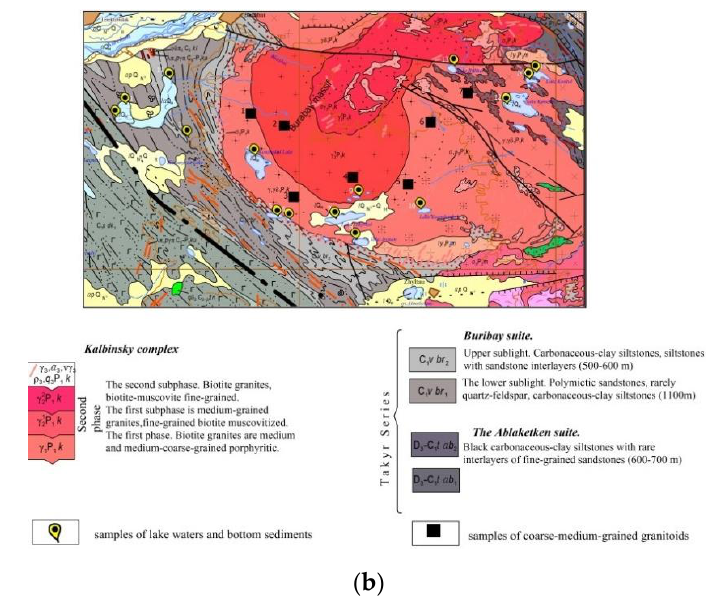
Figure 2. Burabay rock-mass district: ( a )—relief and location of the analyzed lakes; ( b )—geologic map (according to V.P. Solyannik).